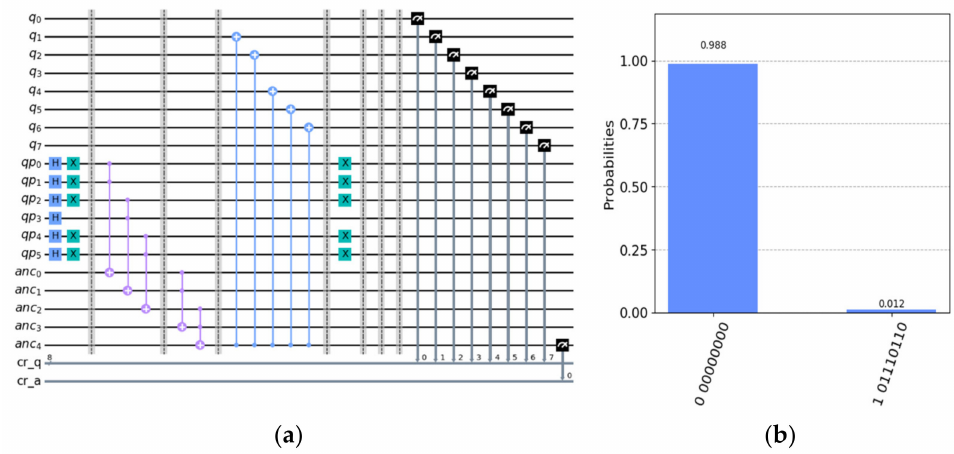
Figure 5. ( a ) The NEQR representation for the second pixel (gray level 118, LSB set to 0) and ( b ) the measurement results.